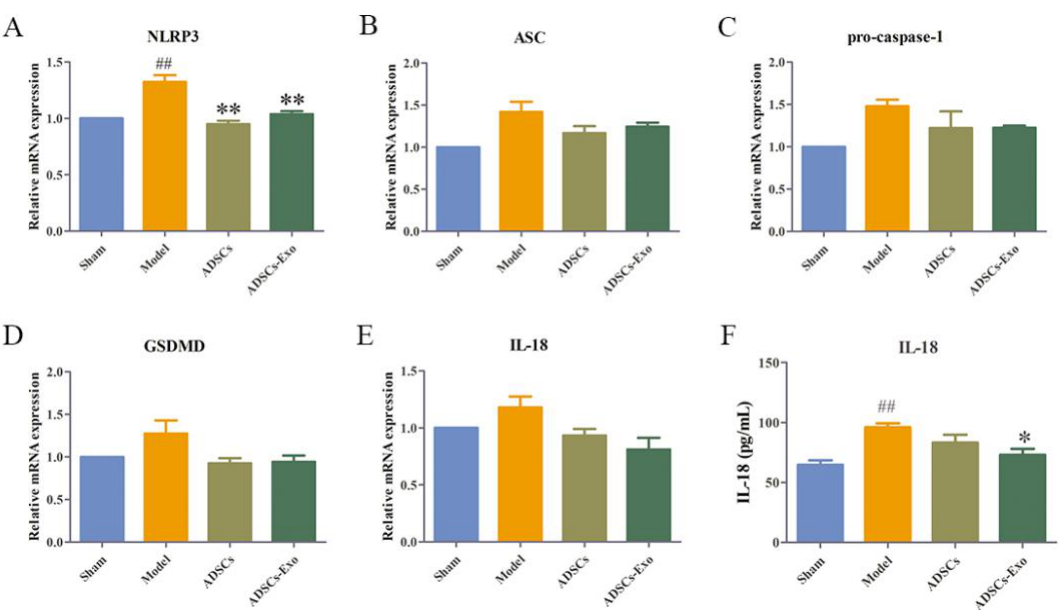
Figure 1. ADSCs-Exo decreased the gene expression of pyroptosis in the liver. Level of NLRP3 ( A ), ASC ( B ), pro-caspase-1 ( C ), GSDMD ( D ), and IL-18 ( E ) in the liver in different groups. Level of IL-18 protein in the level in different groups ( F ). The data are expressed as mean ± SD. ## p < 0.01, versus the Sham group. * p < 0.05 and ** p < 0.01, versus the Model group.